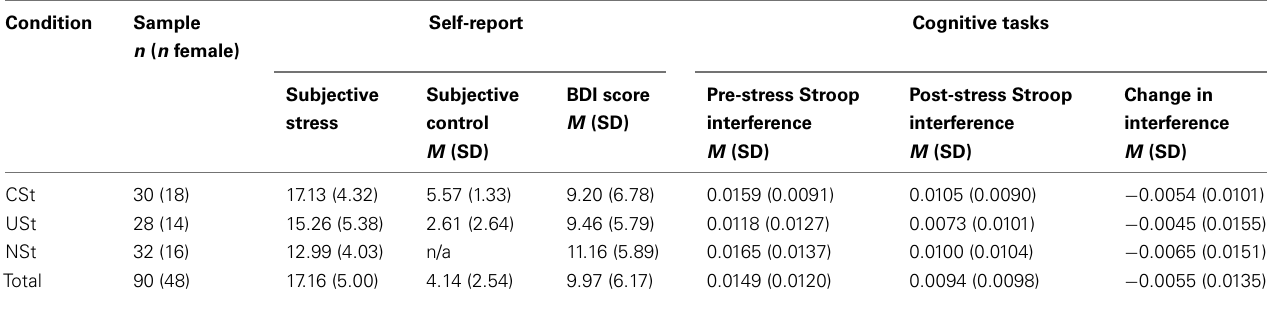
Table 4 | Demographics and descriptive statistics for Experiment